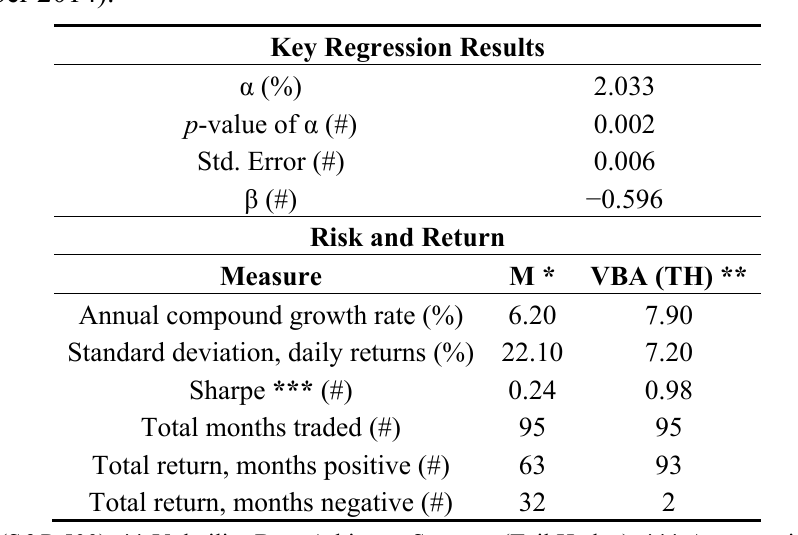
Table 2. Bimonthly Performance of Volatility Beta-Arbitrage—Tail Hedge (October